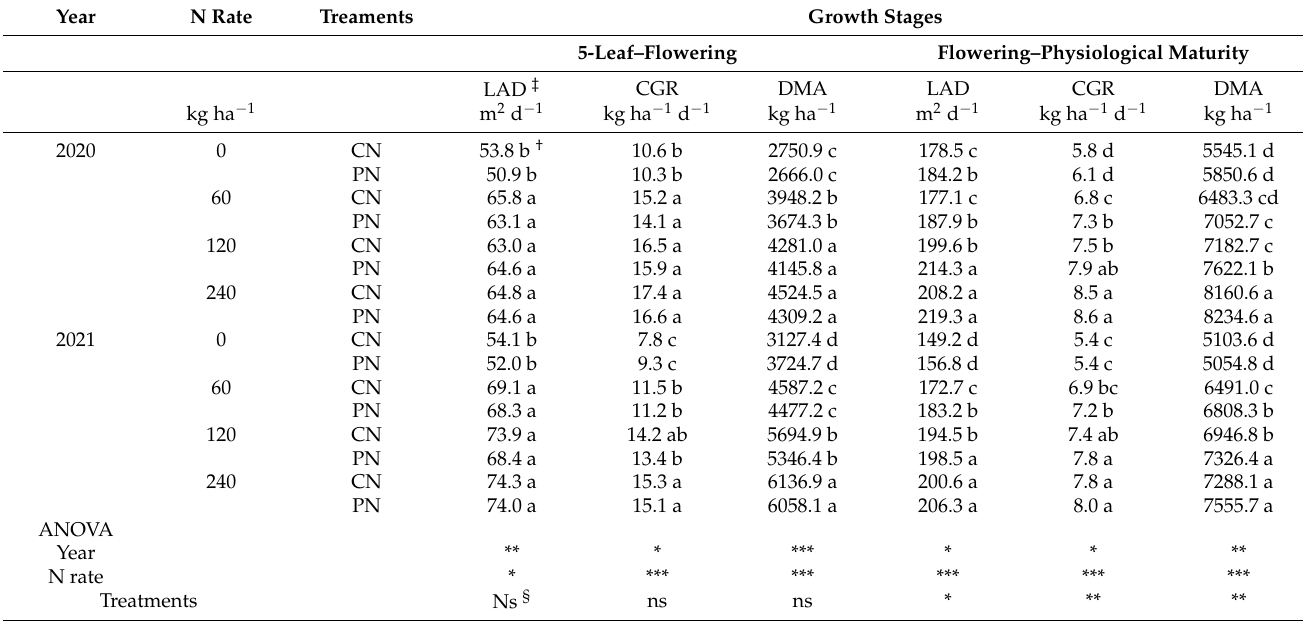
Table 1. Sorghum agronomic traits during the 5-leaf-flowering and flowering-physiological maturity growing stages at four nitrogen fertilizer rates under control treatment (CN) and polyaspartic acid- coated urea (PN) in 2020 and